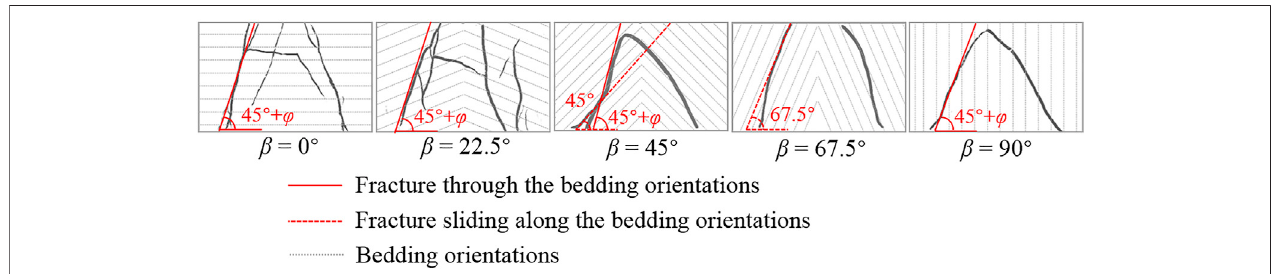
FIGURE 8 | Failure characteristic of rock B with different bedding dip angles after the triaxial test.